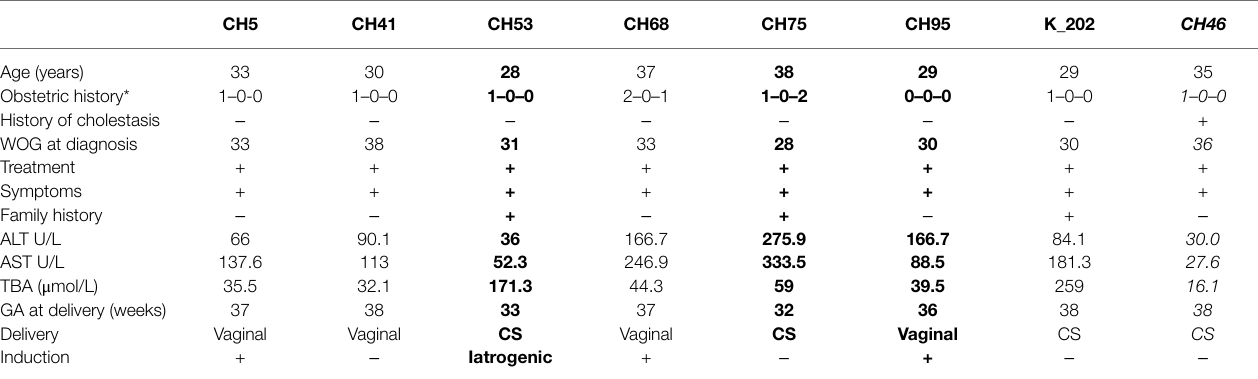
TABLE 2A | Demographic and clinical characteristics of PI*MZ heterozygotes ( n = 7) and PI*MS ( n = 1, highlighted in italics) identified in the group of 103 patients with intrahepatic cholestasis of pregnancy (ICP; premature births marked in bold).